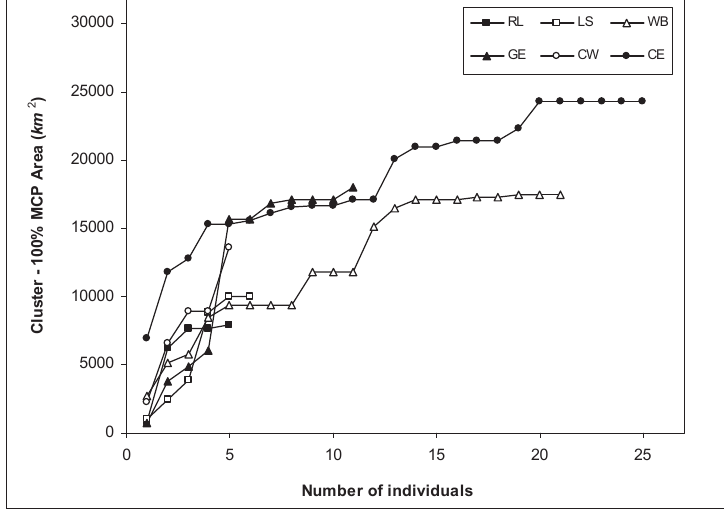
Fig. 7. The relationship between cluster size and the number of classified individuals with locations used to generate the cluster size estimate. Relationships are displayed separately for each identified cluster. The six clusters included are labeled as follows: Red Lake = “RL”, Lac Seul = “LS”, Wabakimi = “WB”, Geraldton = “GE”, Cochrane West = “CW”, Cochrane East =